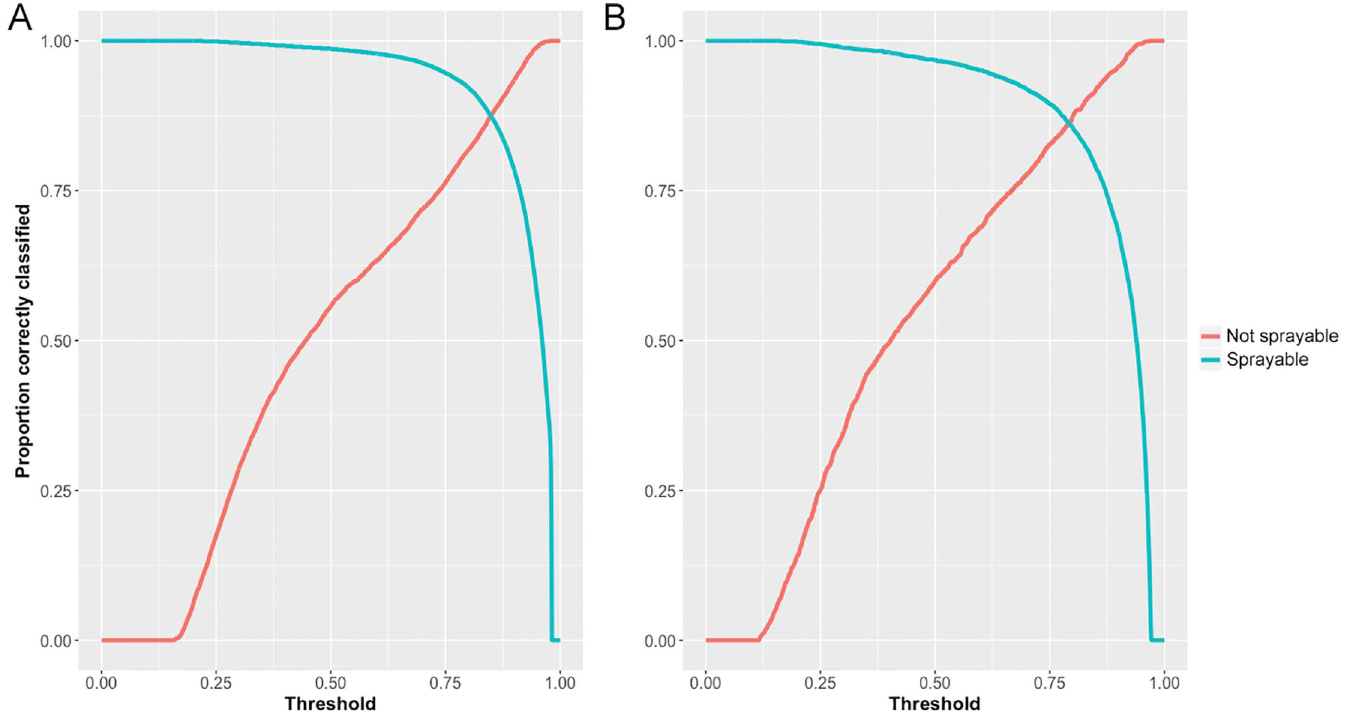
Fig 4. Classification performance of the super learner model under different cutoff values for A–Botswana and B–Swaziland.